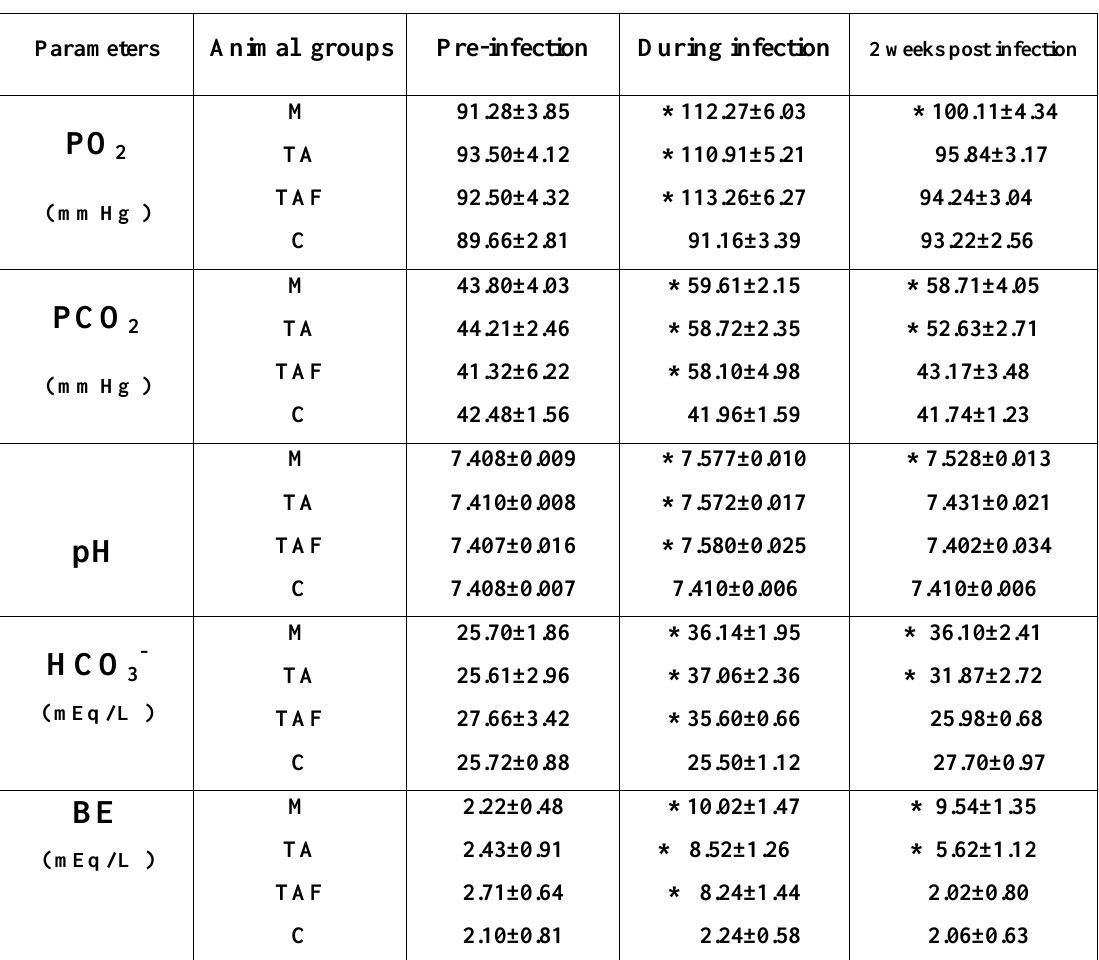
-) and base excess 3